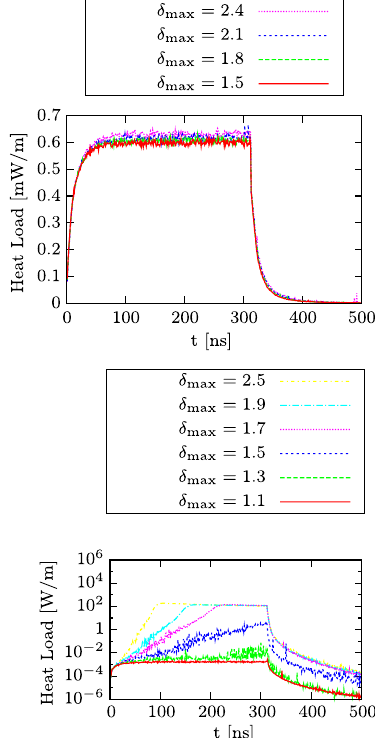
FIG. 10. Heat load induced by electron clouds in the electron damping ring (top). Heat load induced by electron clouds in the positron damping ring